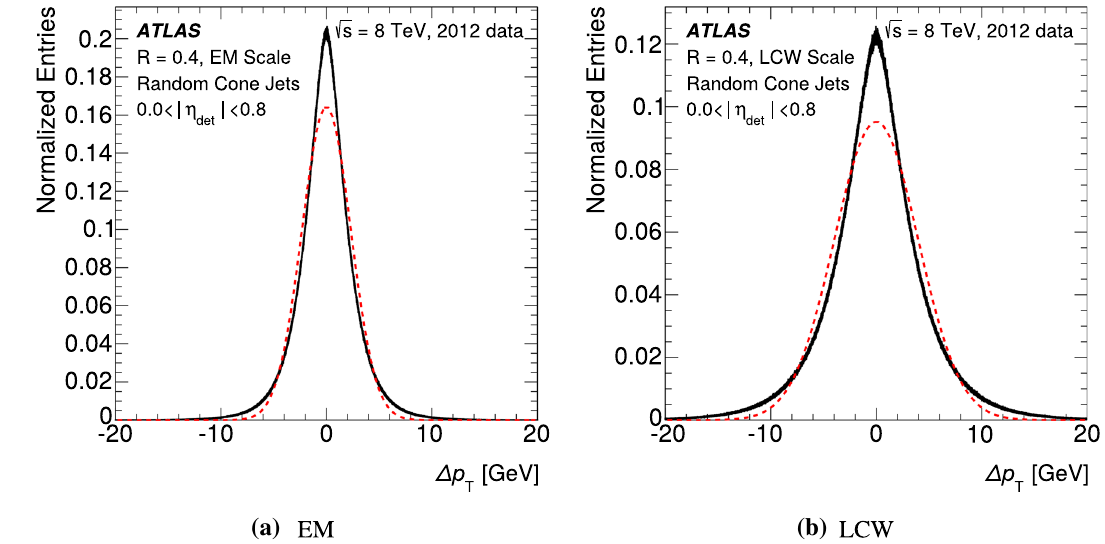
− p 2 ) in the central region | η | < 0 . 8 in 2012 zero-bias data using EM and LCW T T